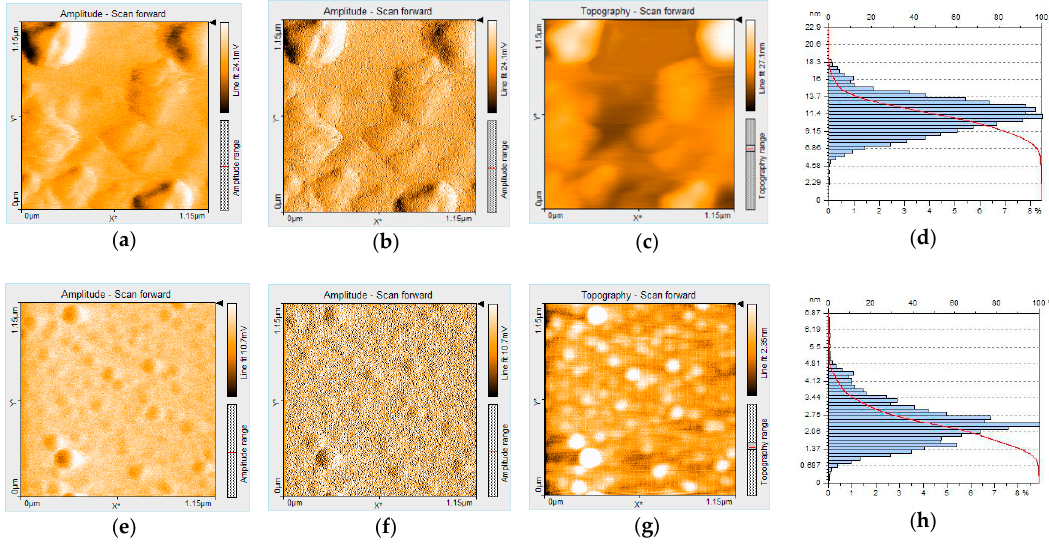
Figure 7. Atomic force microscopy (AFM) images (color and shadow map), topography and size distribution for PtTMeOPP from tetrahydrofuran (THF) solution ( a – d ) and after treatment with bromide ( e – h ).